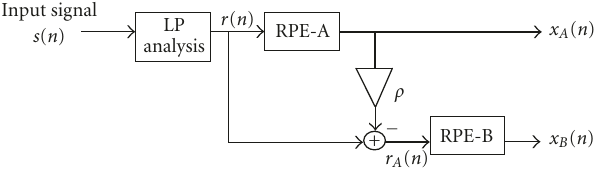
Figure 4: Scheme of the proposed bit stream scalable RPE coder.